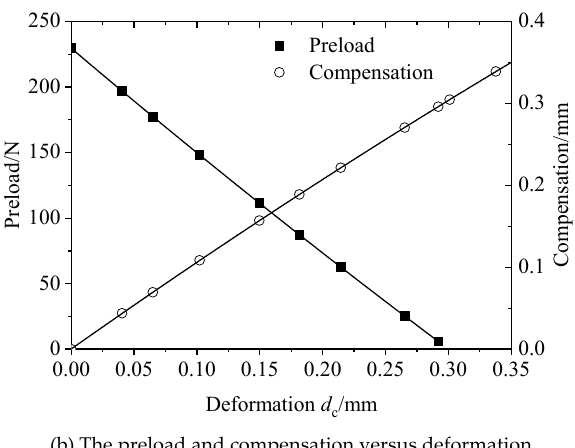
Figure 8. Relationship between deformation again preload and compensation.